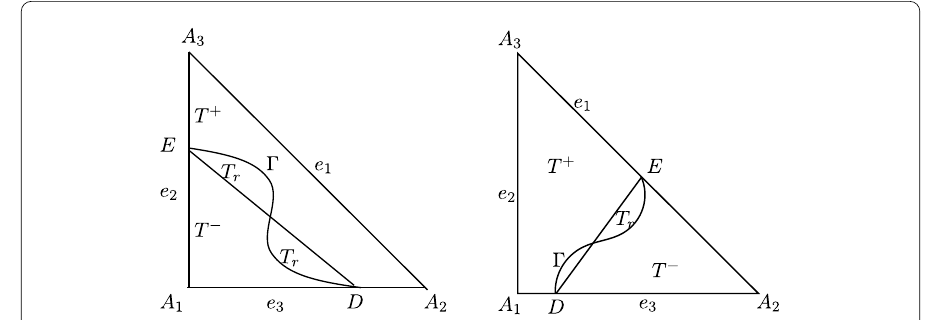
Figure 2 Type-1 (left) and Type-2 (right) interface triangular